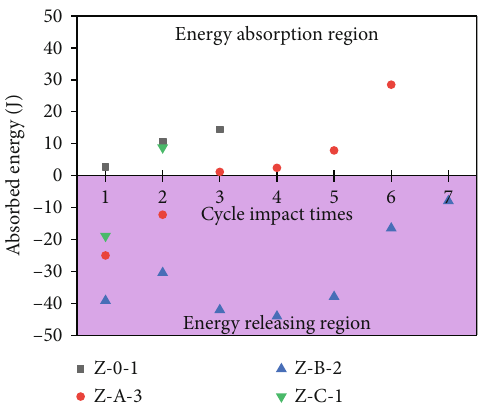
Figure 11: Relationship between axial the prestress and absorbed